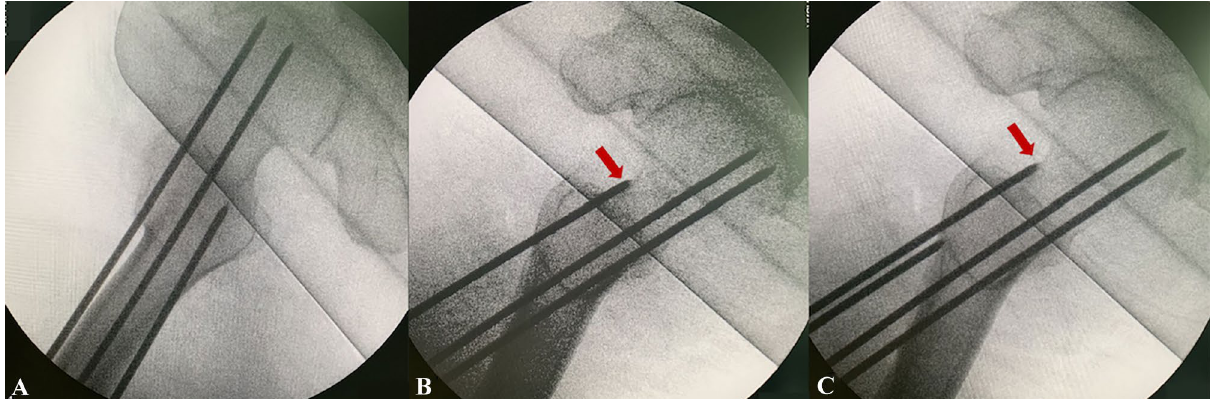
Figure 4. Tangential view instructs femoral neck screw guide wire implantation. ( A ) Intra-operative the lateral views showed the posterosuperior screw guide wire were contained within the femoral neck. ( B ) Intra-operative the tangential view showed the posterosuperior screw guide wire IOI. ( C ) Adjust the guidewire under the tangential view.